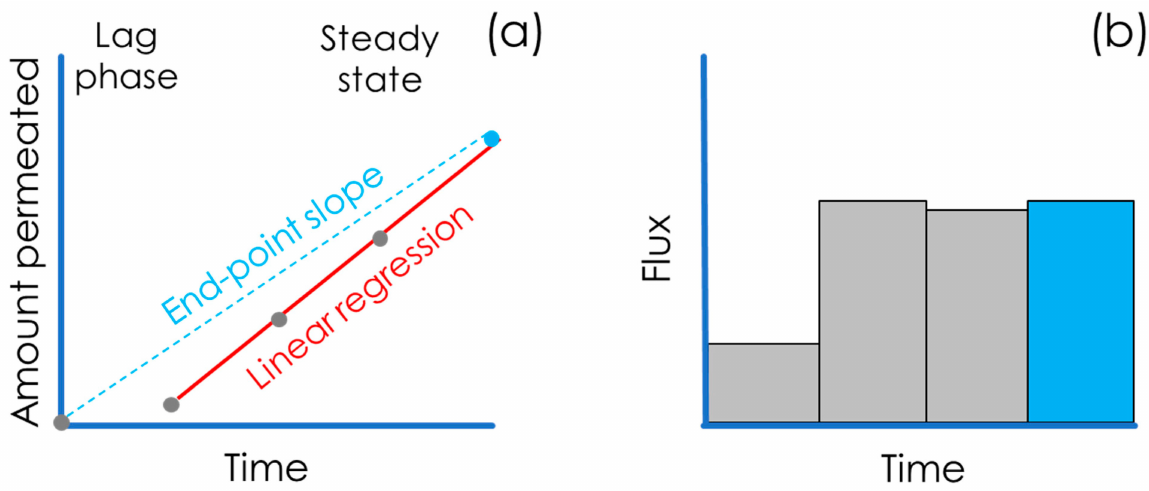
Figure 7. Plot of the amount of drug permeated vs time ( a ) and profile of the flux vs time ( b ). In general, permeability assays suffer from a lag phase, in which the flux is not constant. The interpolation interval of the linear regression (( a ) red line) for measuring the mass flux should thus be carefully selected in order to avoid the misinterpretation of the data and achieve the best possible coefficient of determination (e.g., >0.9). The end-point approach for calculating P app (( a ) light-blue line) leads to lower absolute P app values than in the multiple-point